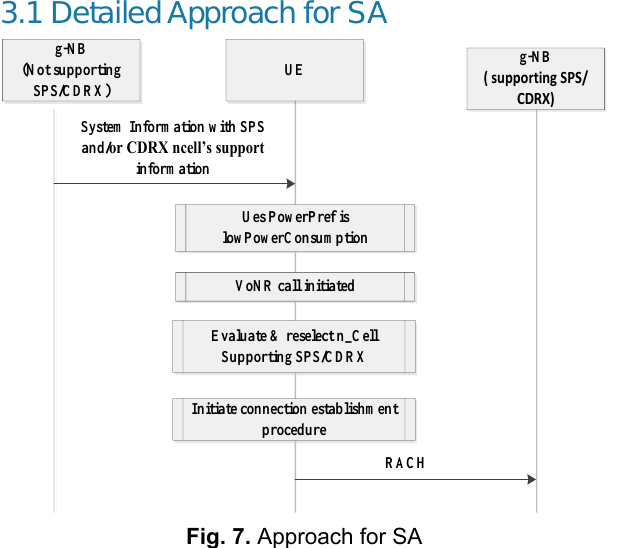
Fig. 6. NSA, Option7, Fig. 5. SA, Option